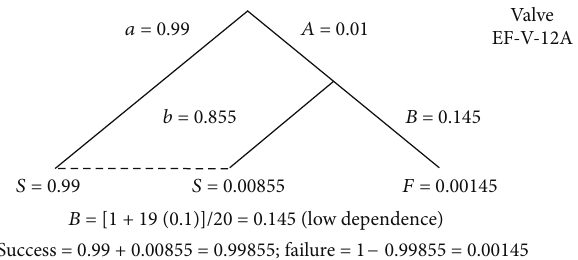
Figure 1: Low dependency between teams in Task 𝐵 .